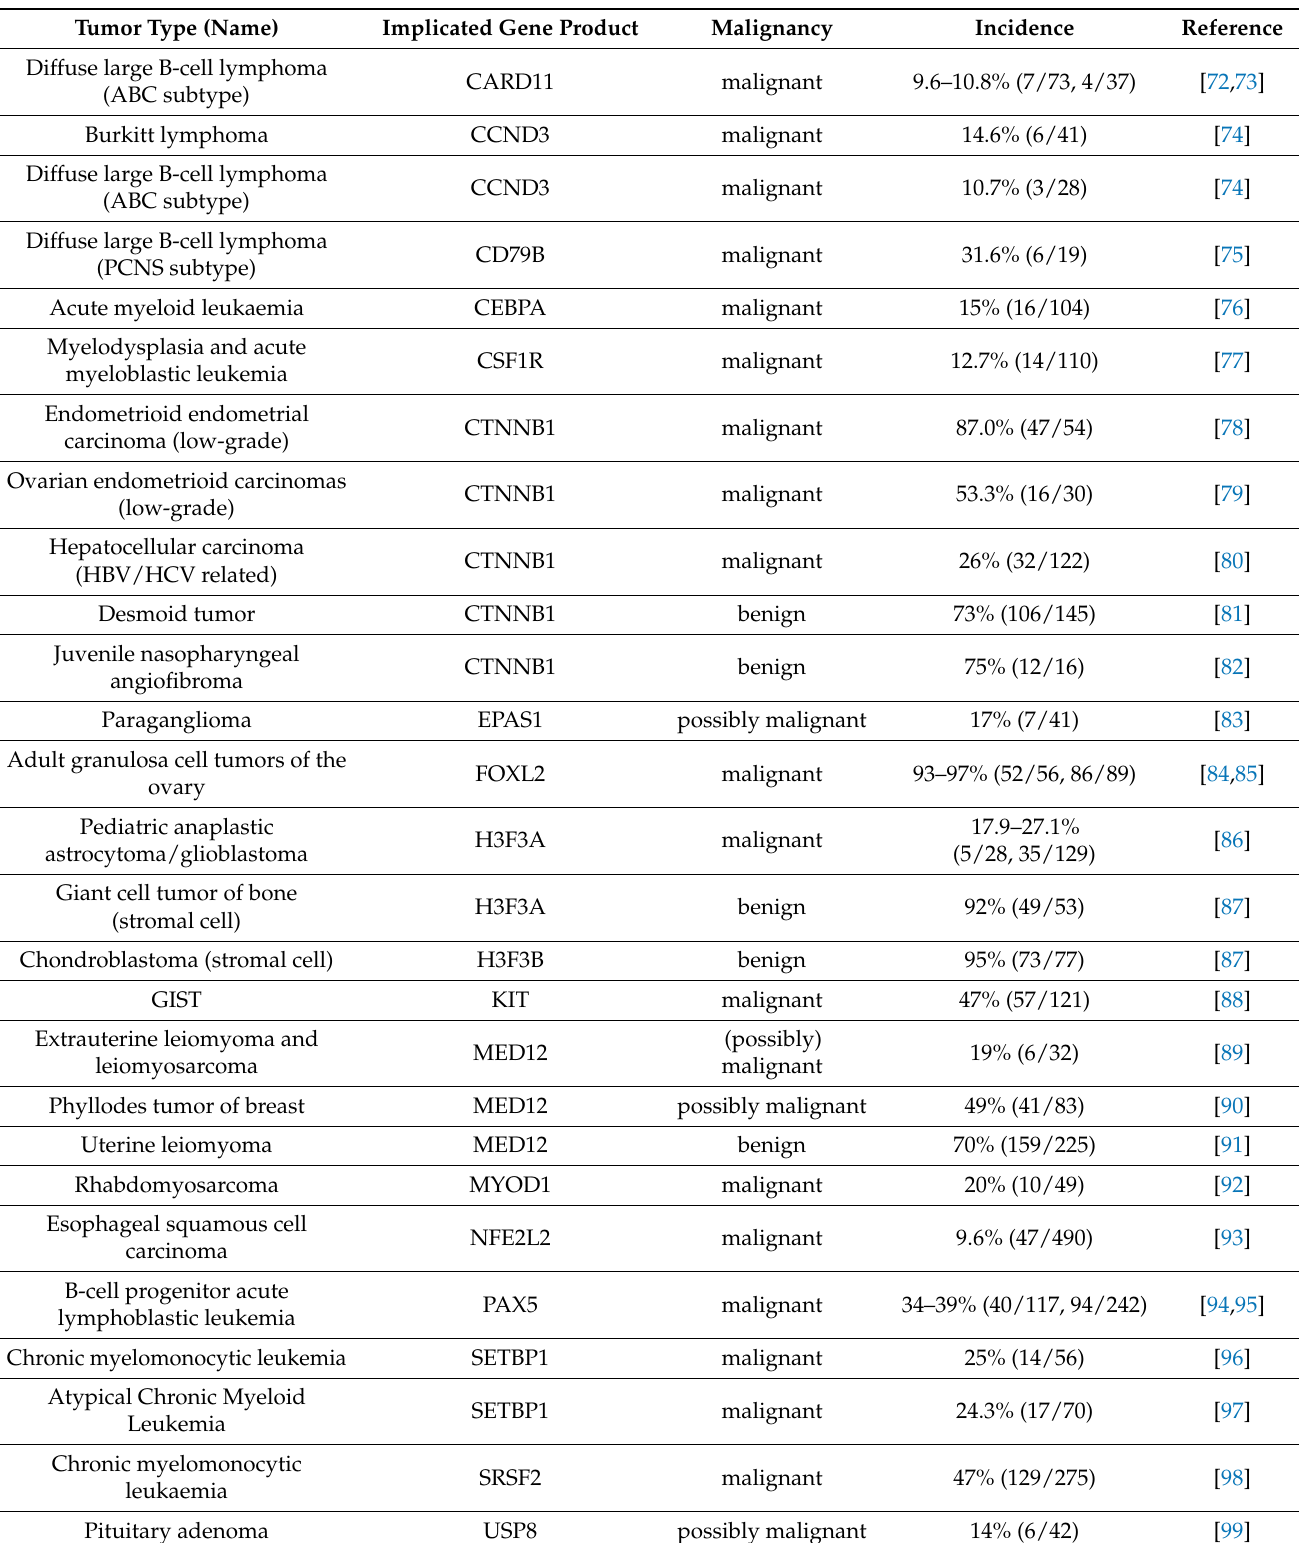
Table 1. Cancer types with mutation incidence rates around or above 10% in the disordered driver gene of interest per total patients